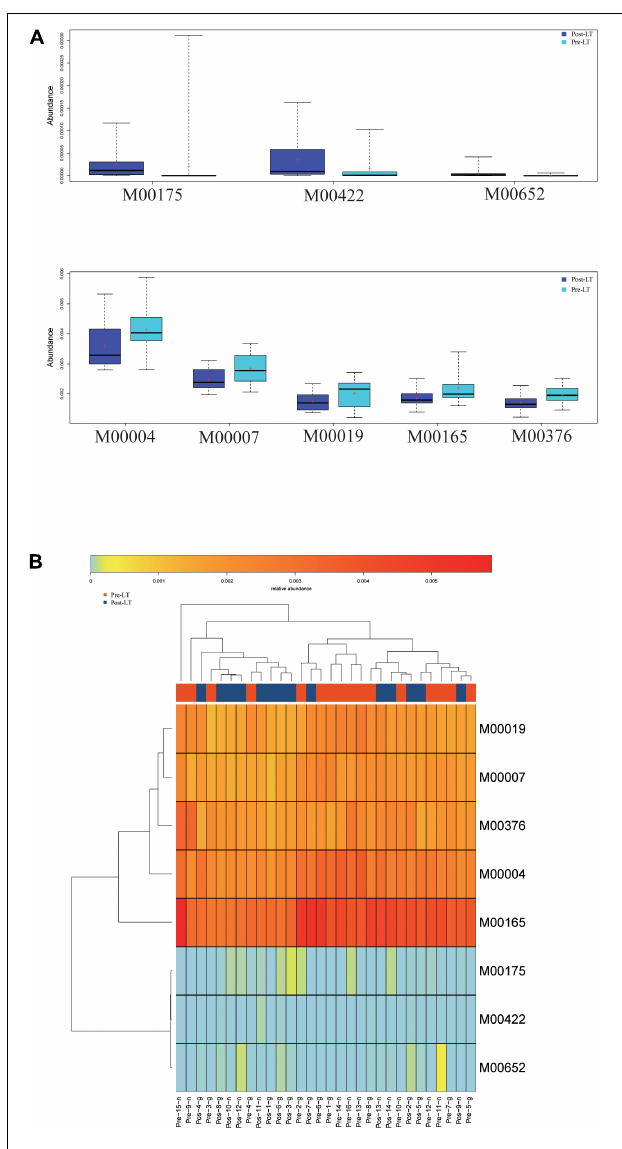
FIGURE 3 | (A) Functional profiles with significantly different abundances at the module level between the pre-LT and post-LT groups (Wilcoxon rank-sum test, P < 0.05). Different colors represent different groups. (B) Hierarchical clustering between differential modules and